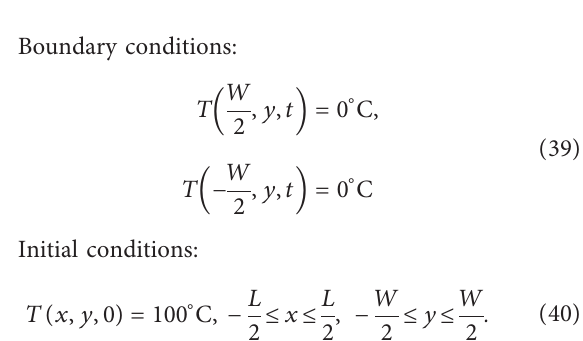
Figure 7: Temperature values for symmetric boundary